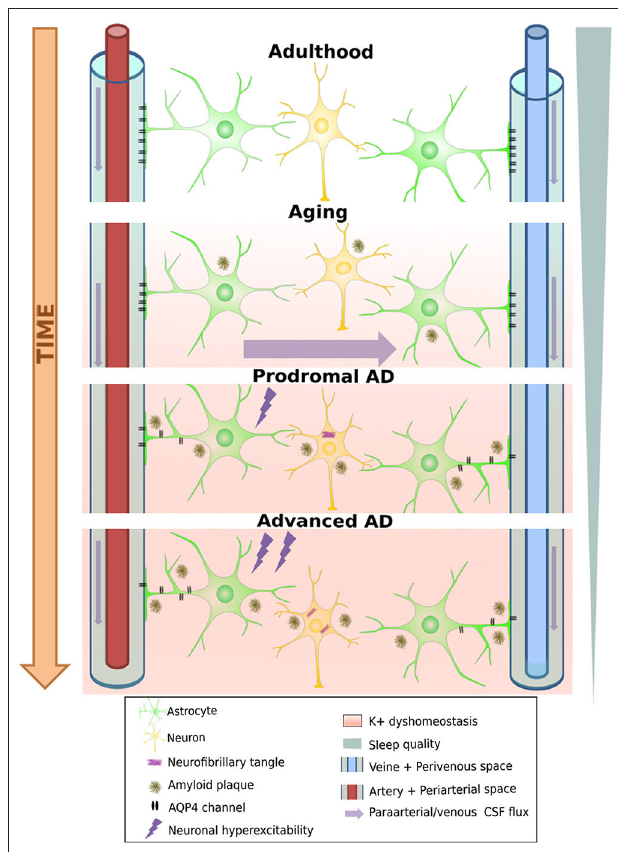
FIGURE 2 | Degeneration of the glymphatic clearance system during healthy aging and Alzheimer’s disease. White band represents time passing over the course of aging turning into neural pathology, including loss of AQP4 channels and their eventual loss of polarity on astrocyte endfeet. This leads to a loss of K + homeostasis, which can already induce neuronal hyperexcitability, increasing A-beta production, further aggravating the process. On the other hand, progressive sleep loss also decreases glymphatic function, which amplifies all the other pathological processes mentioned as